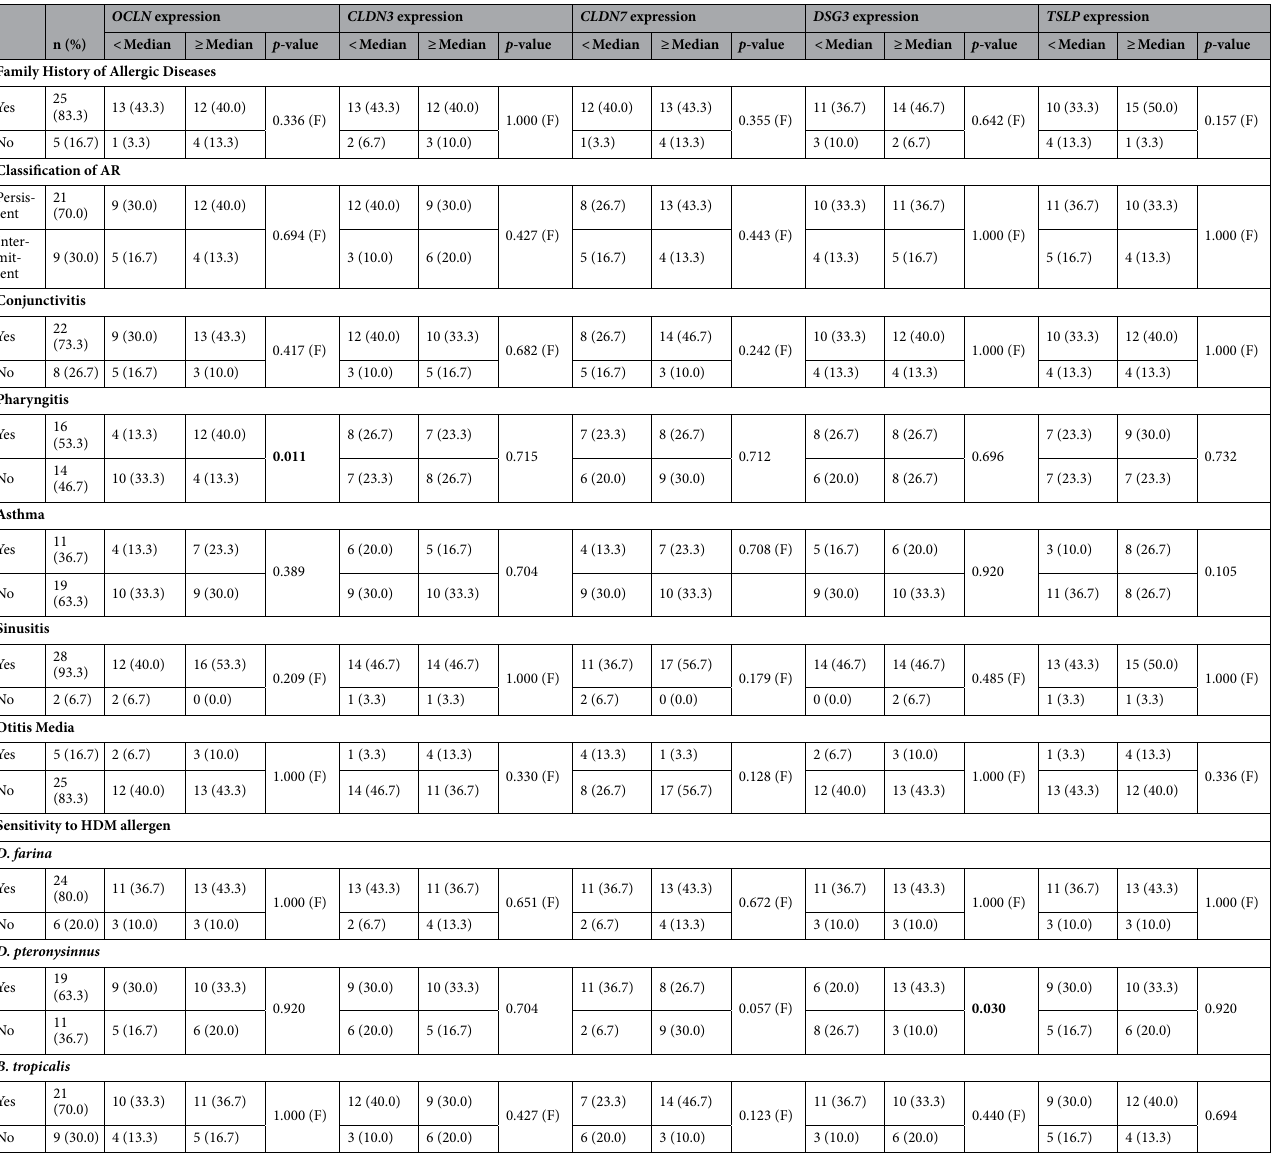
Table 3. Association of OCLN , CLDN3, CLDN, DSG3 and TSLP expression with clinical parameters of AR patients (n = 30). p < 0.05 shown in bold. Abbreviation: AR, allergic rhinitis; OCLN , occludin; CLDN3 , claudin-3; CLDN7 , claudin-7; DSG3 , desmoglein 3; TSLP , thymic stromal lymphopoietin; HDM, house dust